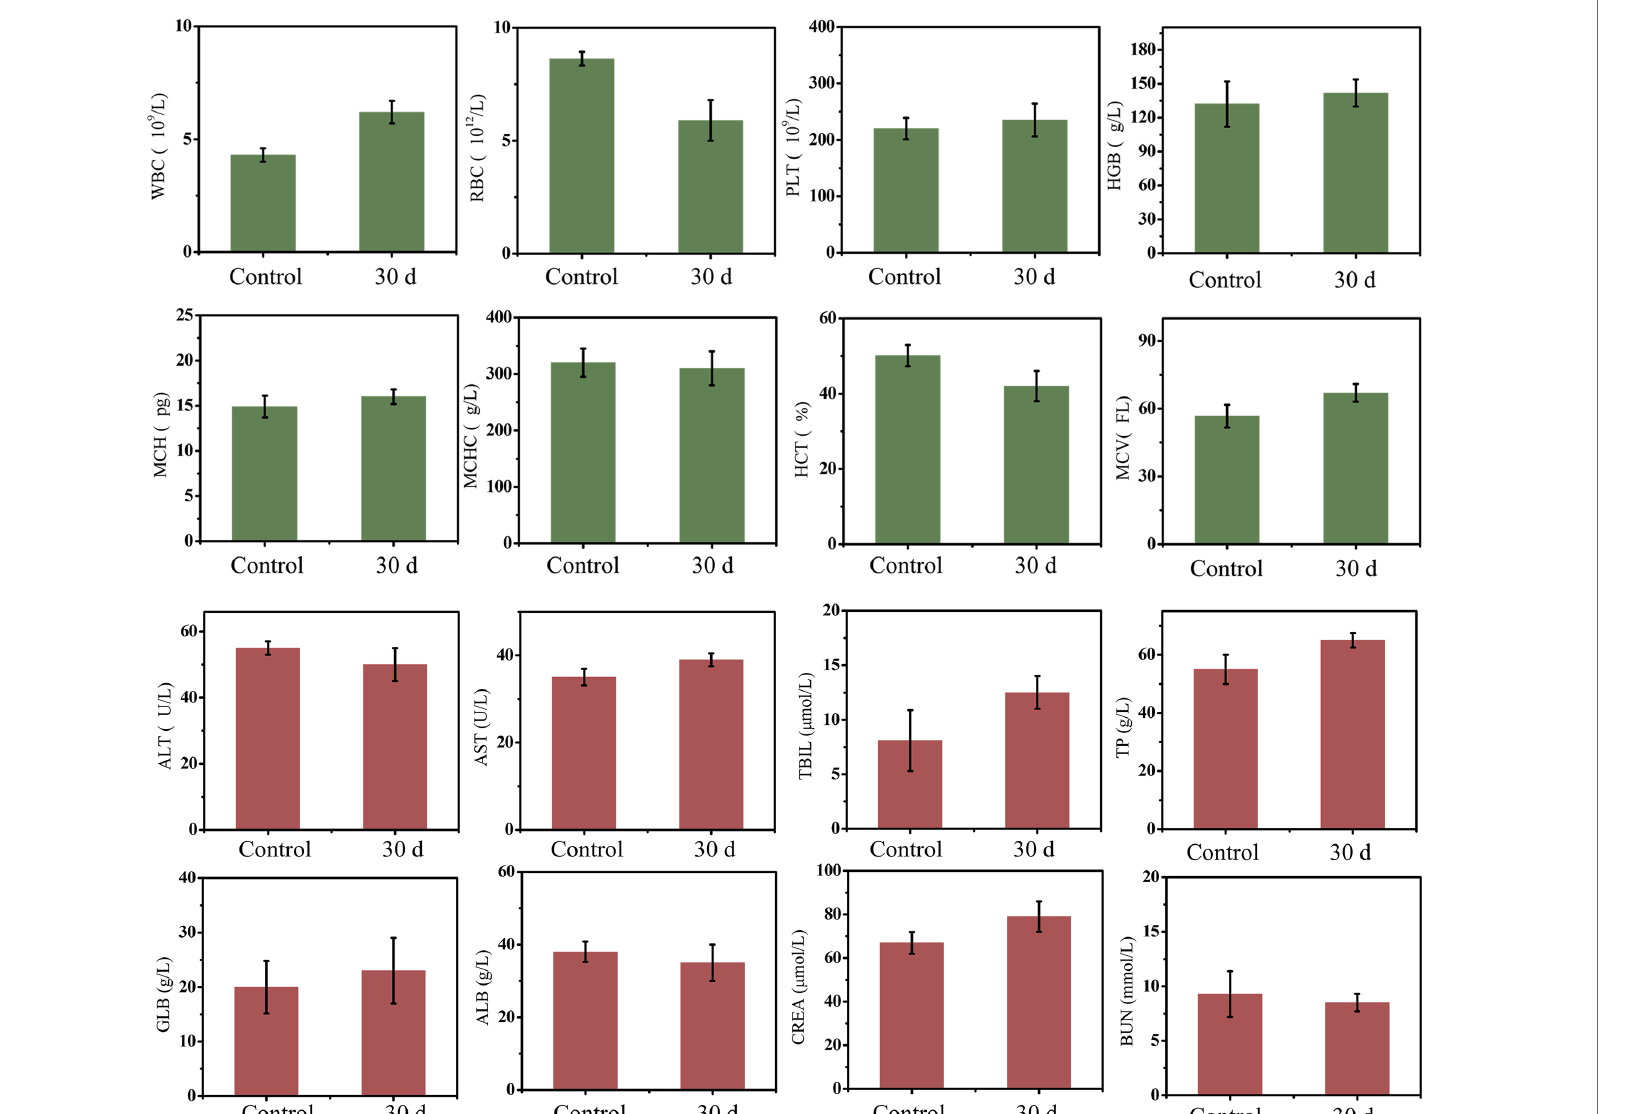
FIGURE 4 | Mice blood testing and biochemical examination, there is no evitable changes in two